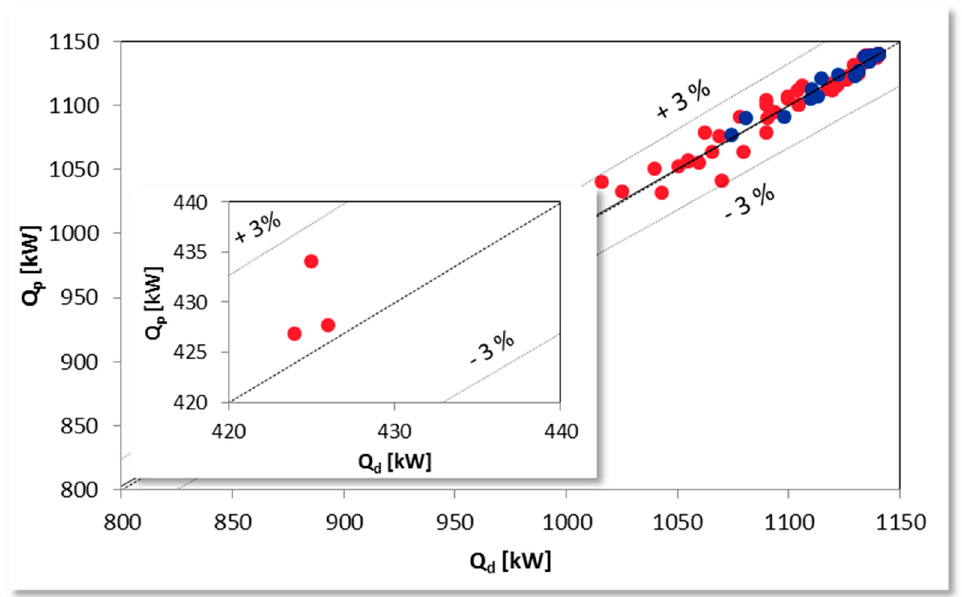
Figure 5. Comparison of the total heat transfer rate of the large falling fill evaporator desired and predicted by the AGENN model (red symbols (cid:8) refer to training while the blue ones (cid:8) apply to the new, testing data set).